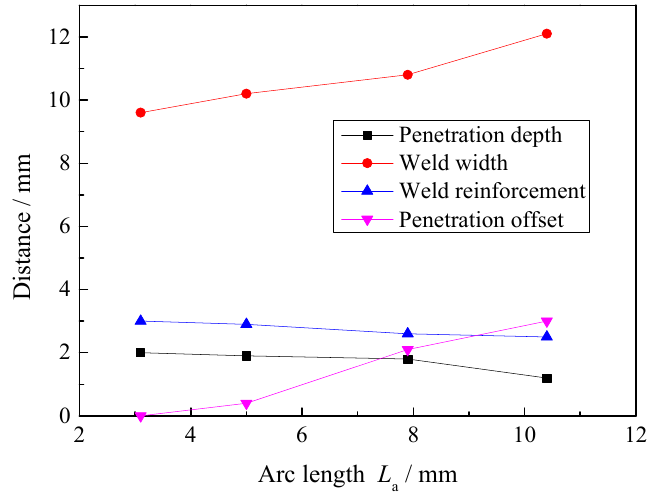
Figure 9. The relationship of arc length and parameters of cross section formation in the projected transfer zone.